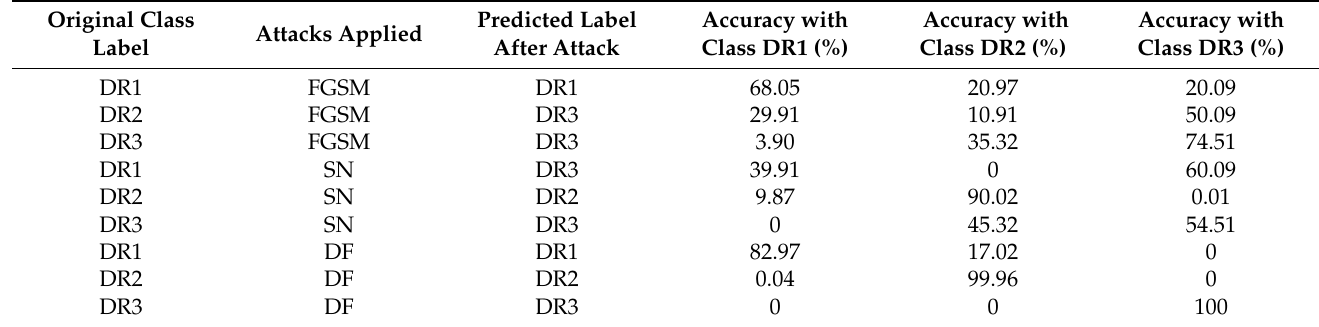
Table 5. Testing of Adversarial Training AT3 Network with Attack Images.